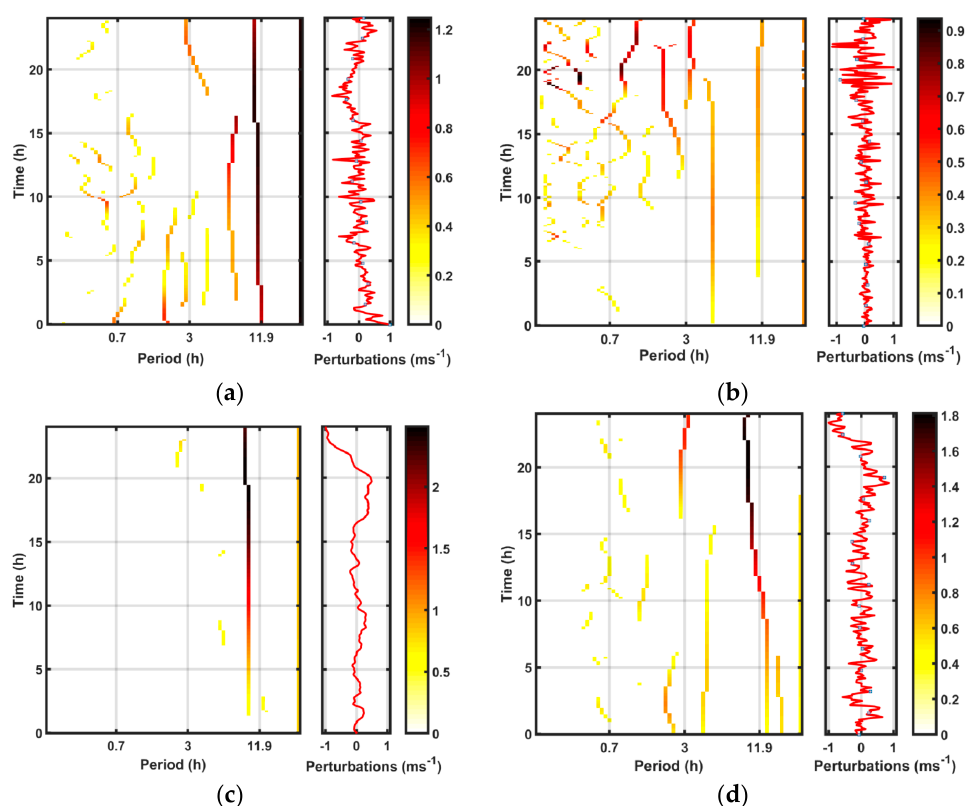
Figure 14. Time evolution of dominant periods (right) derived from the CWT spectral lines of normalized wind perturbations (left) located ahead of the TC (124 ◦ E, 24.3 ◦ N) at 20 km height for ( a ) zonal wind and ( b ) vertical wind. Part ( c ) and ( d ) are the same as Figure 14a,b but at the rear of the TC (131.2 ◦ E, 24.3 ◦ N). Time starts from 6 August 18:00 UTC and ends on 7 August 18:00 UTC.